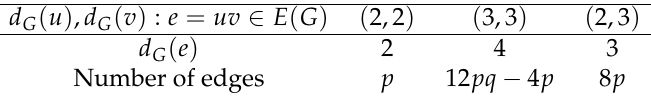
Table 7. Edge degree partition of HC 5 C 7 [ p , q ] .